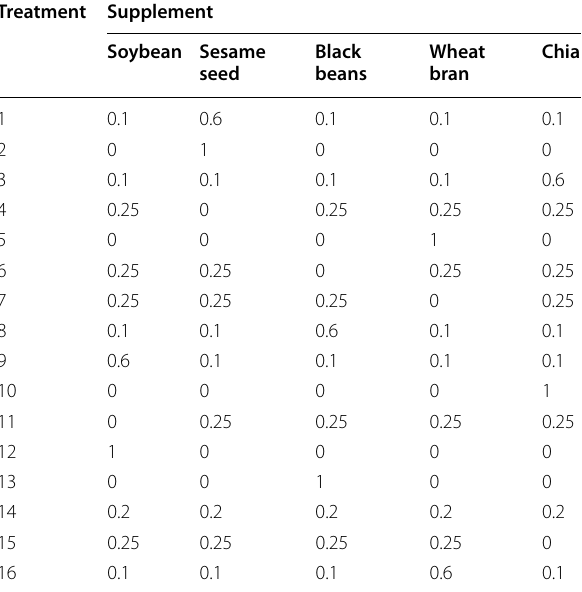
Table 2 Treatments used in the second supplementation trial (five ingredients) for the cultivation of A. bisporus on self-heated pasteurized Pangola